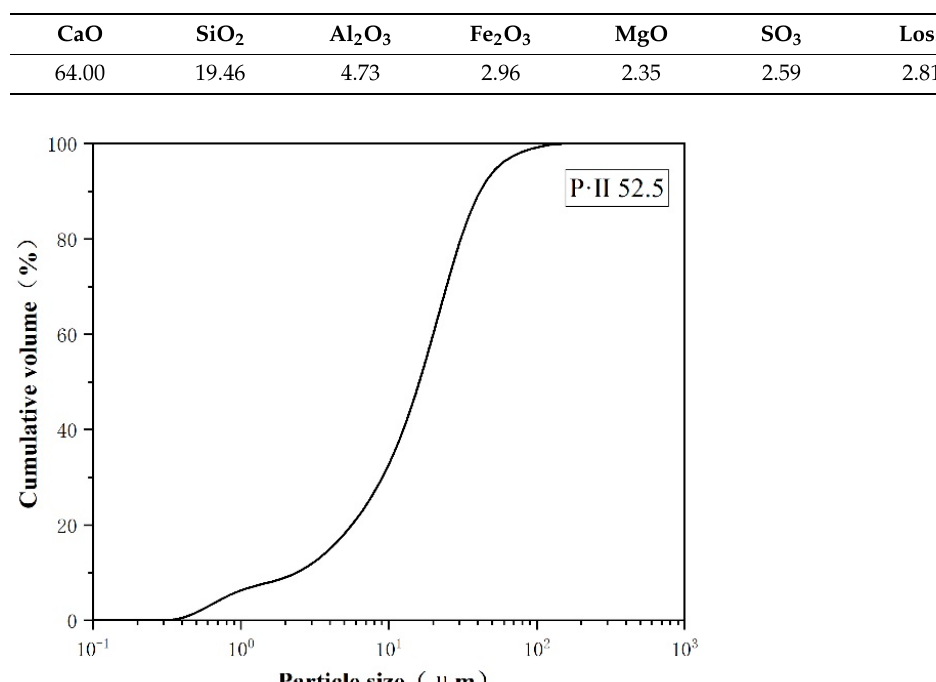
Table 1. Chemical composition of P · II 52.5 Portland cement/wt%.